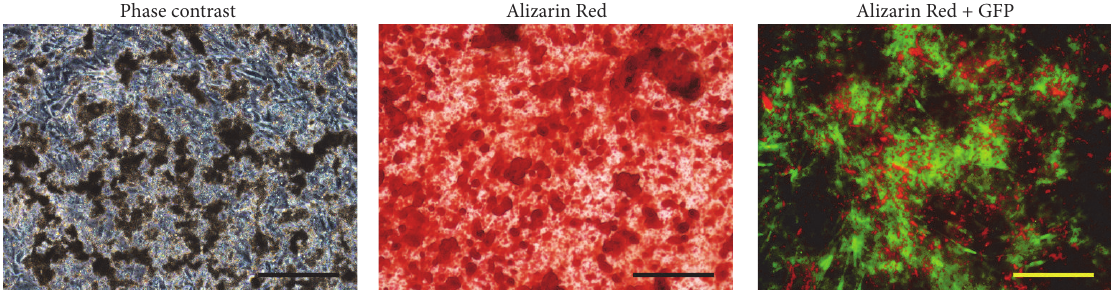
Figure 5: Osteogenic differentiation of GFP-expressing hESC-OPs demonstrated using Alizarin Red staining. Scale bar: 200 𝜇